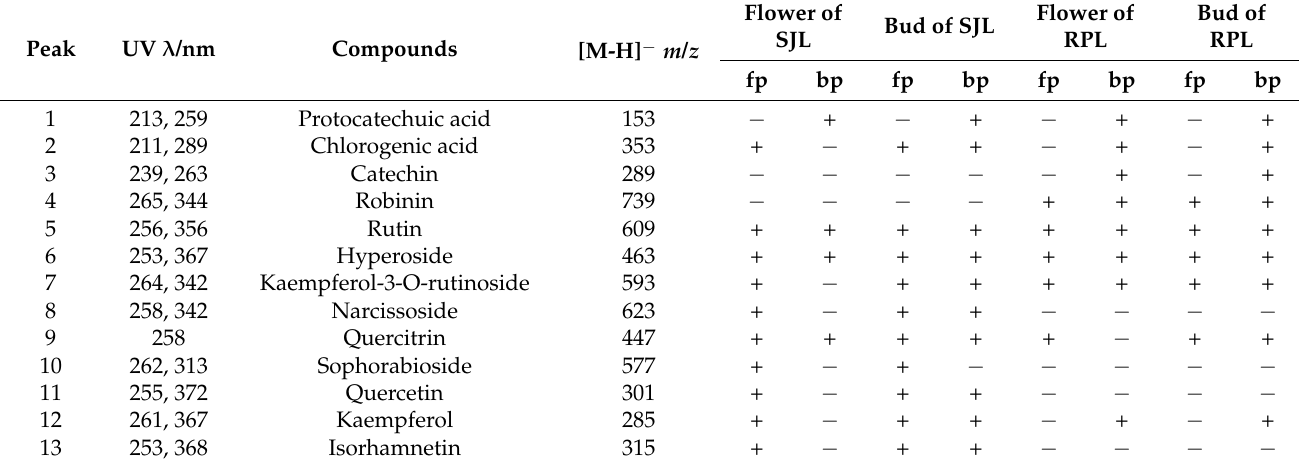
Table 6. Mass spectrometric data, and identification of polyphenols extracted from SJL and